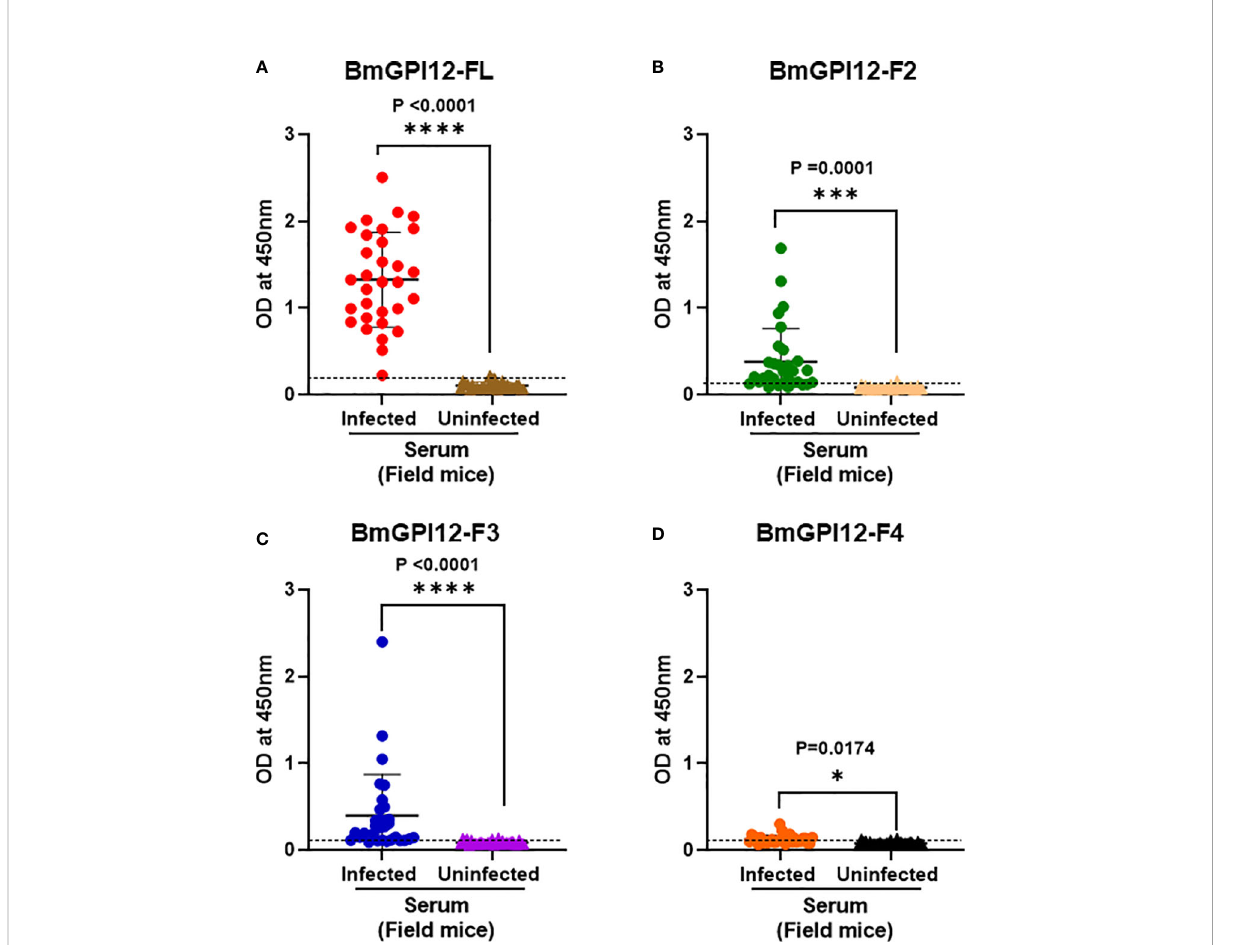
FIGURE 7 Immunodetection of recombinant BmGPI12 or sub-fragments using serum samples from wild mice. ELISA plates were coated with recombinant BmGPI12- full length (FL) (A) , sub-fragments F2 (B) , F3 (C) and F4 (D) at 50 ng/well. Graphs represent immunoreactivity of Babesia positive and negative wild mice sera (used at 1:200 dilution) to respective coated antigens. Red, green, blue and orange solid circles represent responses of B microti PCR positive samples to recombinant BmGPI12-FL, F2, F3 and F4 sub-fragments respectively. Brown, peach, purple and black solid triangles represent responses of B microti PCR negative samples to recombinant BmGPI12- FL, F2, F3 and F4 sub-fragments respectively. Each assay was conducted more than once with at least two technical replicates per assay. Error bars denote the standard deviation calculated using the Graphpad Prism 9.3 software. The OD 450 cut-off (dashed line) denotes the mean + 2 x SD of the OD 450 value of the negative samples. ****: statistically signi fi cant (p<0.0001, by two-way ANOVA); ***: statistically signi fi cant (p=0.0001, by two-way ANOVA); *: statistically signi fi cant (p=0.017, by two-way